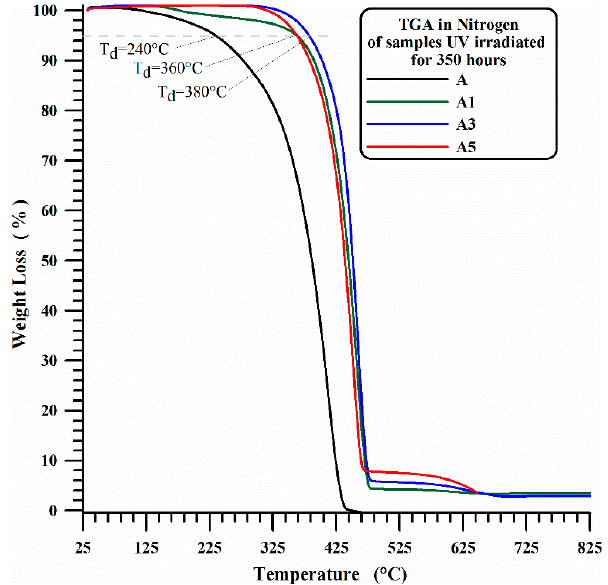
Figure 4. TGA in nitrogen of iPP (A) and iPP-MWCNT nanocomposites (A1, A3, A5) after 350 h UV irradiation.